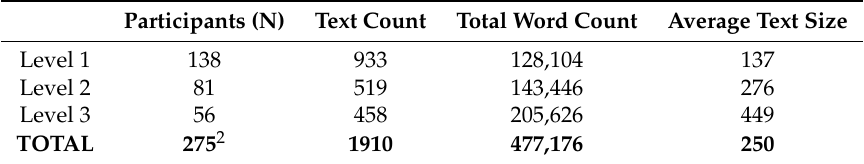
Table 4. Distribution of participants, texts, total word count, and average text size across the Table 3 Portuguese courses. Note that the di ff erence in total number of participants is due to 63 participants being in more than one level (longitudinal